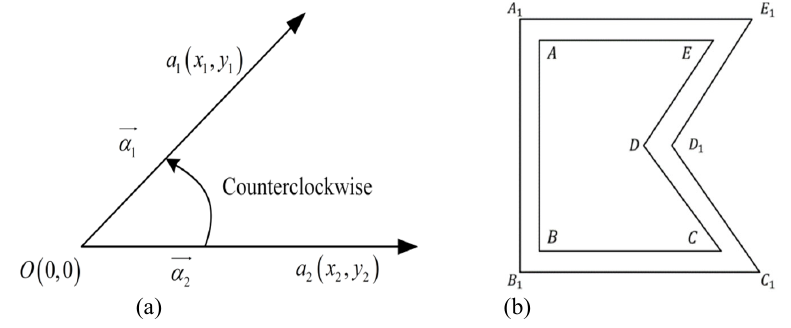
Fig. 2. (a) Schematic of vector cross product, (b) Schematic of equidistant offset of piece ABCDE